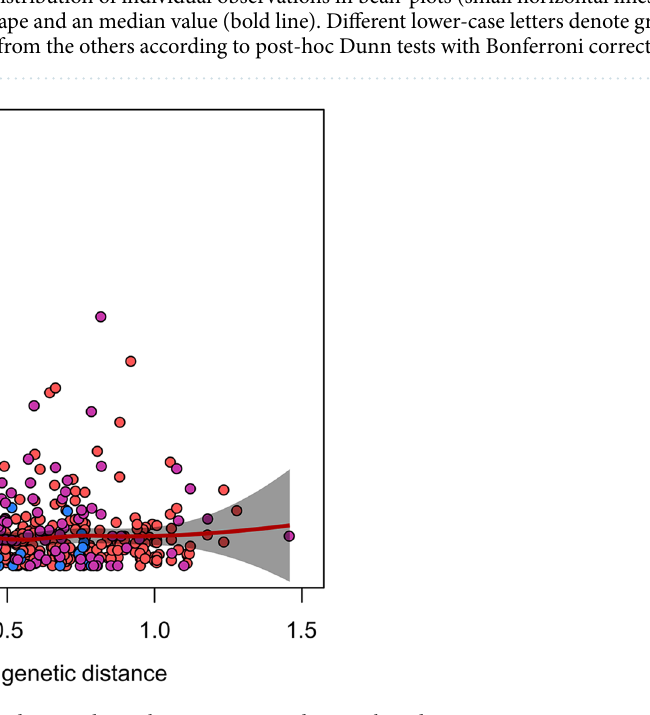
Figure 4. Spearman’s rank-order correlation between genetic distance based on PCoA components and relative swarming activity of individuals. Local polynomial regression curve fits the deterministic part of the variation in the data with 95% confidence interval. Different demographic categories of individuals (adult females, adult males, juveniles) are colour-coded as in Figs. 2 and